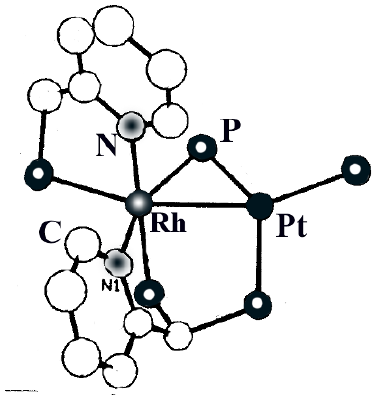
Figure 8. Structure of Structure [(Ph